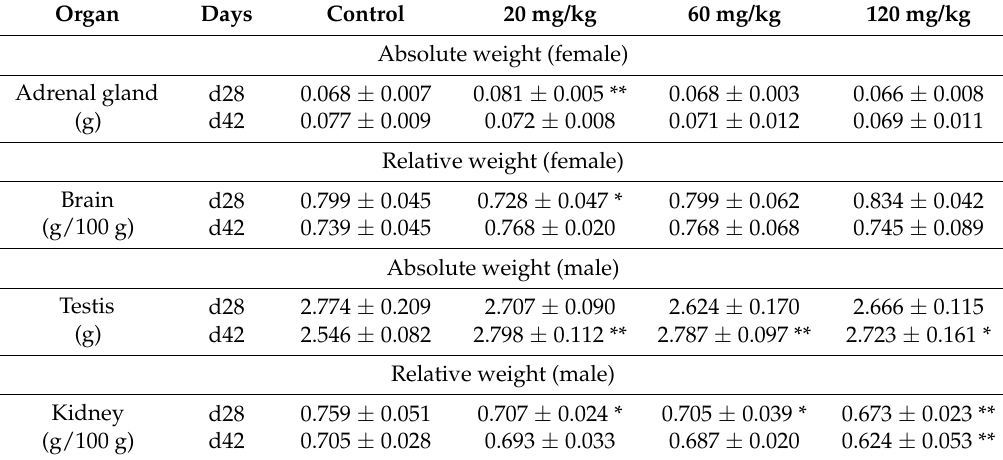
Table 8. Selected absolute and relative organ weights induced by HZ1006 in rats following repeated dose administration after 28 days of continuous treatment and a 14-day recovery (only significant results are listed).